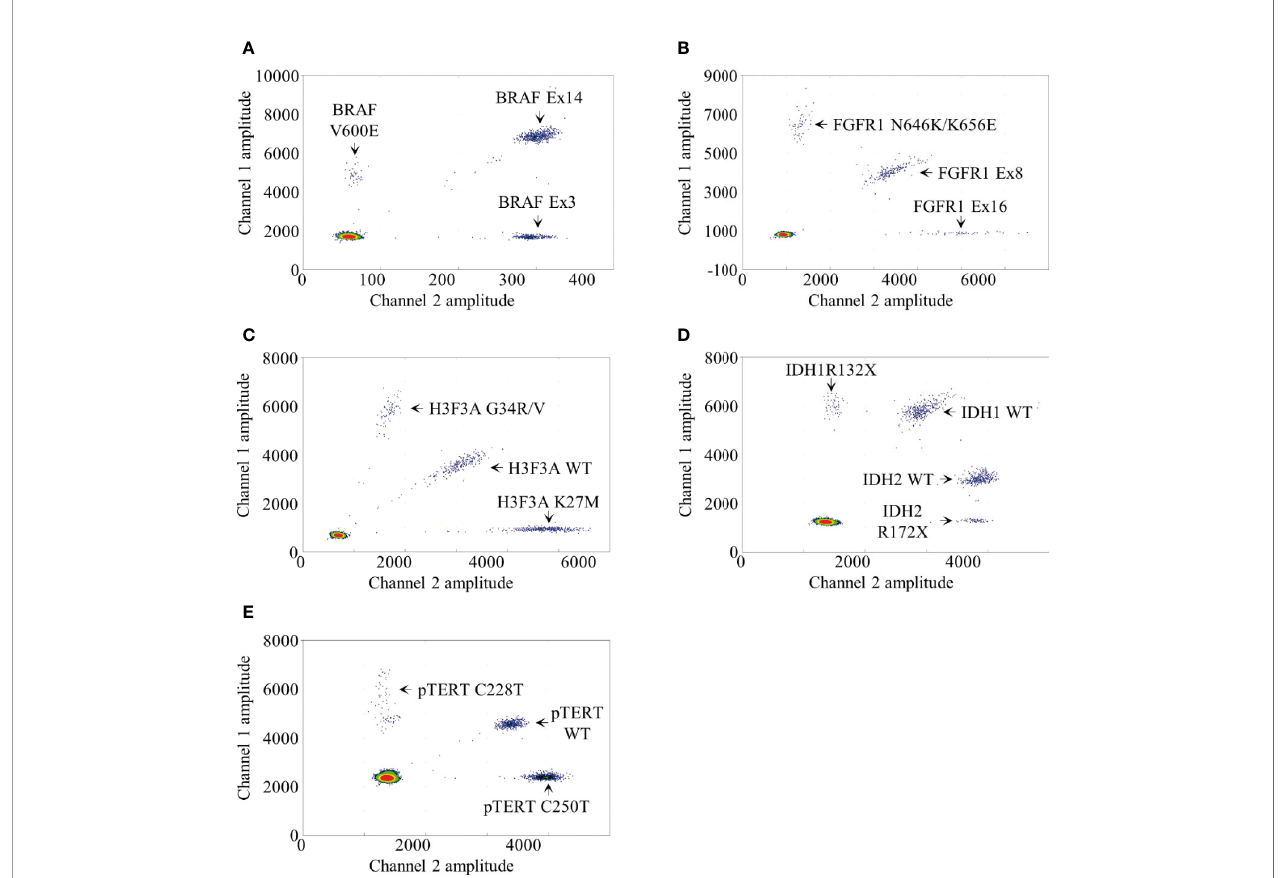
FIGURE 1 | Droplet digital PCR results. Two dimensional representations of the BRAF (A) , FGFR1 (B) , H3F3A (C) , IDH1/2 (D) and pTERT (E) multiplexed droplet digital assays. Fluorescence amplitude at channels FAM and HEX are plotted at Y- and at X-axis, respectively. Each dot on the fi gure represents one droplet, and the corresponding targets are designated for each cluster. Bottom left clusters represent negative